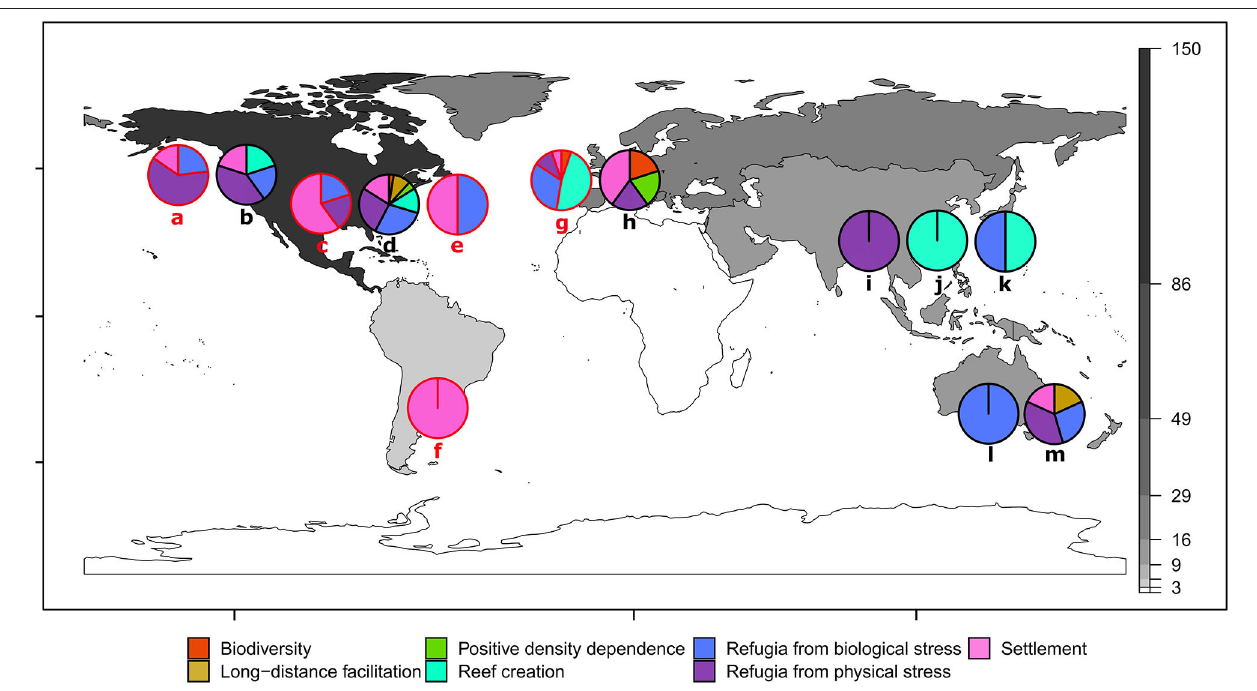
FIGURE 3 | Positive interactions for shellfish restoration summarized for 10 ecosystem-forming oyster species. Continents are color coded by the number of positive species interactions synthesized from the review (e.g., black = 86–150 observations; and white = zero observations). Lower case letters indicate oyster species. Pie charts and letters in red (a, c, e, f, g) show non-native oyster taxa for that region. West coast of North America: (a) Crassostrea (Magallana) gigas , Pacific oyster–non-native (13 obs.); (b) O. lurida , Olympia oyster—native (10 obs.). East coast of North America: (c) Crassostrea (Magallana) ariakensis , Suminoe oyster–non-native (5 obs.); (d) Crassostrea virginica , Eastern oyster–native (118 obs.); (e) C. gigas , Pacific oyster–non-native (4 obs.). South America: (f) C. gigas , Pacific oyster–non-native (3 obs.). Europe: (g) C. gigas , Pacific oyster–non-native (19 obs.); (h) Ostrea edulis , European flat oyster (5 obs.). Asia: (i) Saccostrea culccullata , Natal oyster–native (6 obs.), (j) Crassostrea (Magallana) angulata , Portugeuse oyster–native (2 obs.); (k) C. gigas , Pacific oyster–native (2 obs.). Australasia and Oceania: (l) O. angasi, Australian flat oyster–native (1 obs.); (m) Saccostrea glomerat a, Sydney rock oyster–native (11